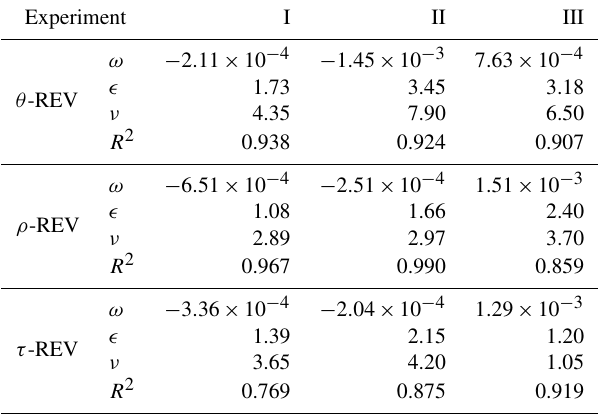
Table 2. The fitted parameters of the models of frequency for REVs of porosity, density, and tortuosity.